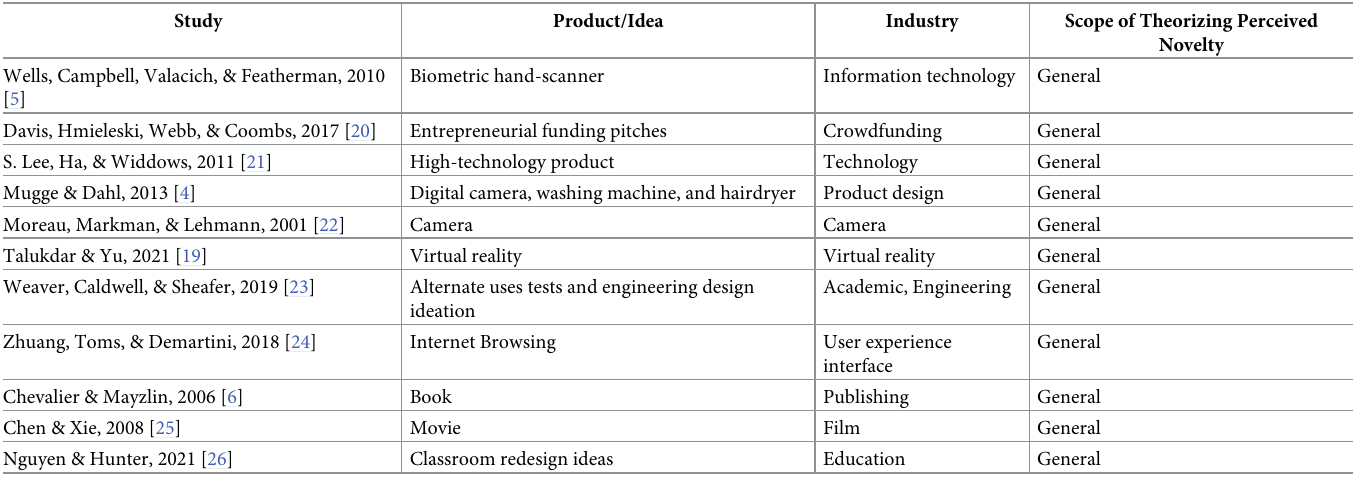
Table 1. Summary of perceived novelty research across products, ideas, and